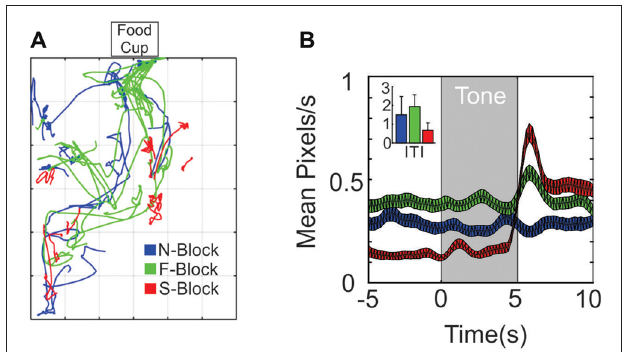
FIGURE 1 | Differences in movement across the three blocks. (A) 10 × 10 s sample movement trajectory segments from the N-block (blue), the F-block (green) and the S-block (red) as obtained from video tracking during a single session. (B) Average (and SEM) rate of movement (pixels/sec) across all animals and sessions during the tone and outcome periods or (inset) during the inter-trial/background